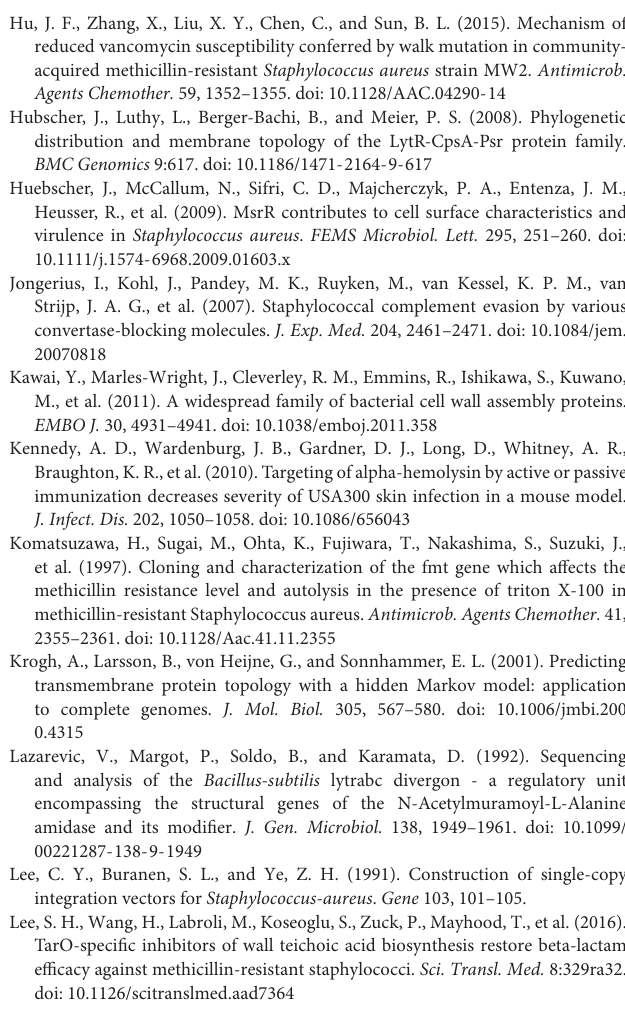
Supplementary Figure 1 | The transcriptional levels of genes related to cell wall synthesis showed little to no differences among the wild-type, lcpB mutant, and complemented strains. The transcriptional levels were evaluated through RT-qPCR. The means and standard deviations were then calculated. Data is presented as the mean ± standard deviations. ∗ p < 0.05. Supplementary Figure 2 | The expression of GST, (cid:49) TM-LcpB, and mutated LcpB. Supplementary Figure 3 | The extraction of WTA. WTA of the wild-type, lcpB mutant, and complemented strains was analyzed by native PAGE and detected by Alcian blue–silver staining. Supplementary Figure 4 | The distribution of arginine in LcpB and the mutation sites of arginine that did not affect the growth. (A) The distribution of arginine in LcpB. (B) Growth of strains with single arginine mutations that did not affect the growth and non-mutant complemented strains. The results were obtained from three independent experiments performed in